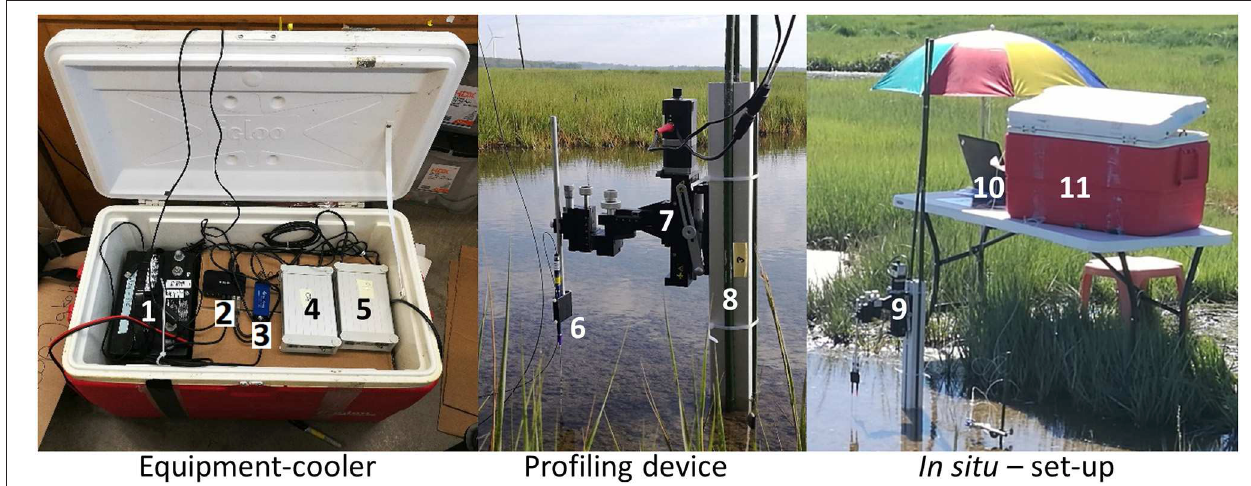
FIGURE 2 | Experimental set-up for in situ microprofiling of O 2 , pH, and CO 2 . Equipment cooler: (1) Car-battery, (2) USB-hub, (3) O 2 -meter, (4) CO 2 -meter, (5) pH-meter. Power inverter, 6-way socket, and individual power supplies are located under the cardboard box. Profiling device: (6) Sensor holder with sensor, (7) Automated Micromanipulator, (8) Aluminum stand with spikes. In situ set-up: (9) profiling device, (10) laptop, (11) equipment cooler.